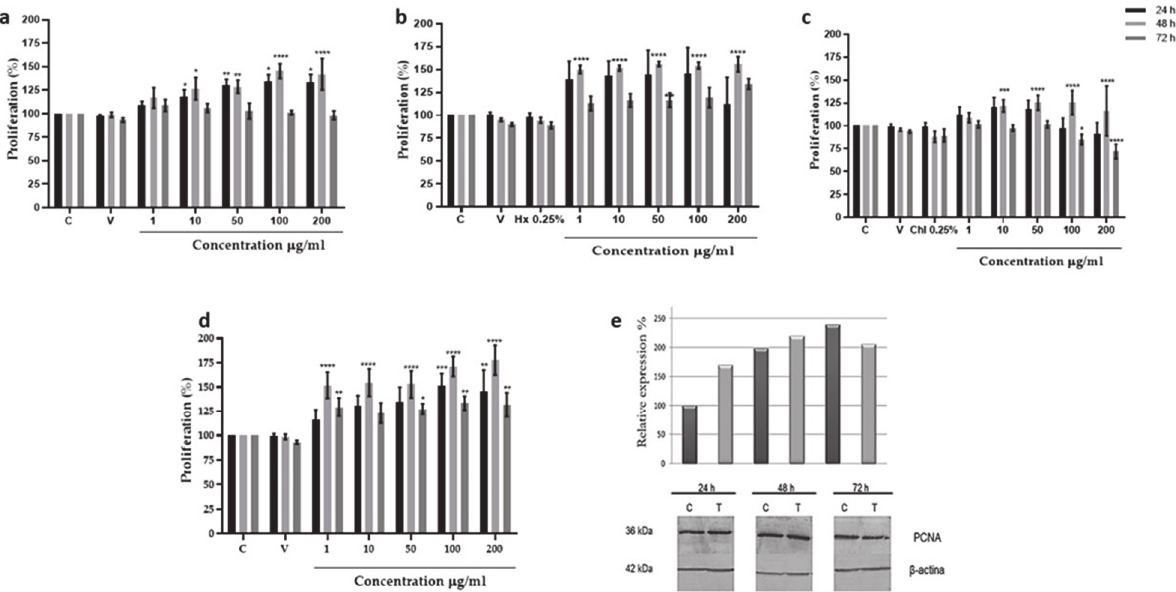
Figure Figure 1. Proliferative effect of Bacopa procumbens extract and fractions on 3T3 fibroblasts. ( a ) Fibro ‐ blasts grown in 2% SFB ‐ supplemented media were treated with TAE, ( b ) Hx, ( c ) Chl, or ( d ) aqueous fractions at 1, 10, 50, 100, and 200 μ g/mL for 24, 48, and 72 h. Cell proliferation was measured by MTT. Control was only 2% SFB, as solvent vehicle (V), fibroblasts were grown with water (for TAE and aqueous fraction) or DMSO (for Hx and Chl), 0.25% hexane (Hx), 0.25% chloroform (Chl), or without any solvent (C). ( e ) Total protein extracts from 3T3 fibroblast treated with 10 μ g/mL of aqueous fraction were extracted, and WB was carried out to analyze PCNA expression using anti ‐